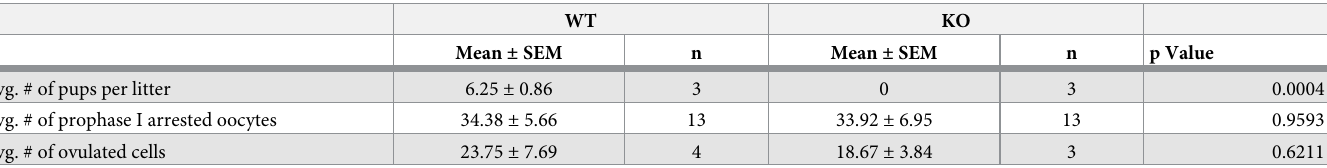
Table 1. Number of pups, oocytes and cells ovulated from WT and Aurka KO